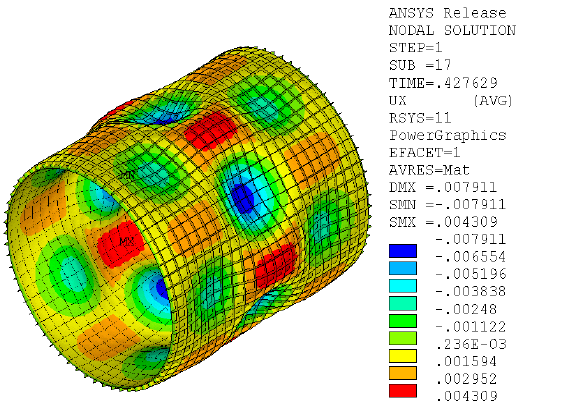
Figure 9. Radial displacement contour map at the critical point of the post-buckling path for the model of the stiffened cylinders with L / R = 2.51 and the SS3 boundary condition when the material is PVC and ξ = 0.05.